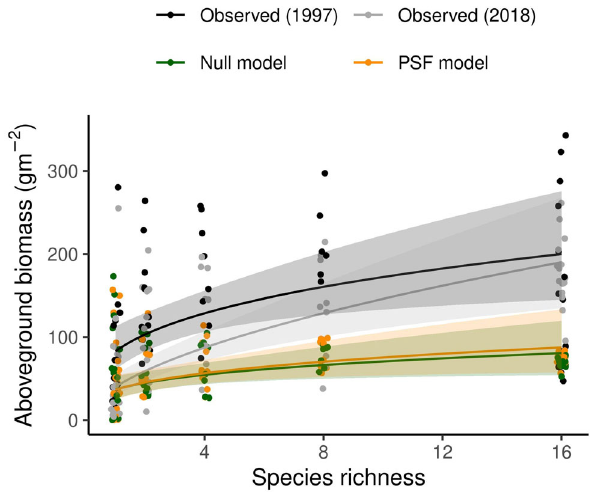
Fig. 2 Observed and predicted plant biomass in experimental plant communities with one to 16 plant species. Plant-community growth simulation models either with (PSF) or without (Null) plant-soil feedback effects predicted that biomass would increase with species richness (i.e. overyield). However, PSF simulation models correctly predicted this effect was caused by complementarity effects and Null models incorrectly predicted this effect was caused by selection effects (Fig. 3). The overyielding predicted by PSF simulation models represented 14% of the overyielding observed in the two biodiversity-productivity experiments. Each point represents total aboveground biomass in one community type ( n = 55 or 63 for the 1997 and 2018 experiments, respectively). Large values from six outlier plots are not shown but were included in analyses. Lines represent the best- fi t curves and shaded areas indicate the 95% con fi dence intervals. In each dataset, biomass increased with species richness ( P < 0.05; see Results for